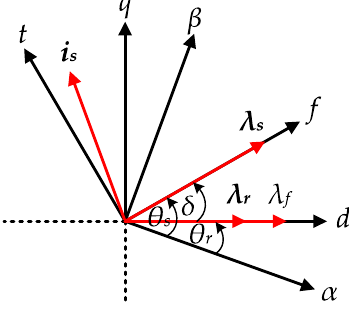
Figure 1. Phasor diagram of the Interior permanent magnet synchronous motor (IPMSM).